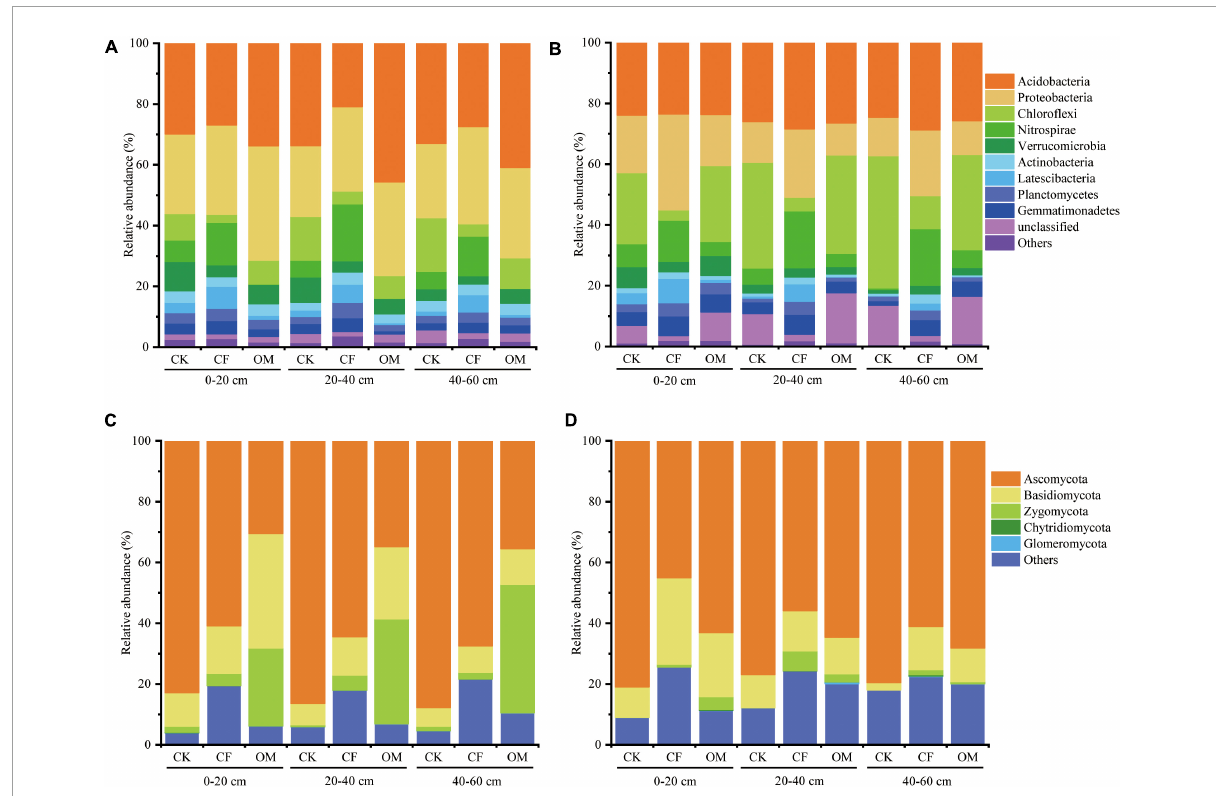
FIGURE1 Distribution and abundance of major bacterial (A,B) and fungal (C,D) phyla in all soil samples with different soil depths. The left column is the samples in the year of 2019, and the right column is in the year of 2020. CK, no fertilization; CF, chemical fertilization; OM, organic